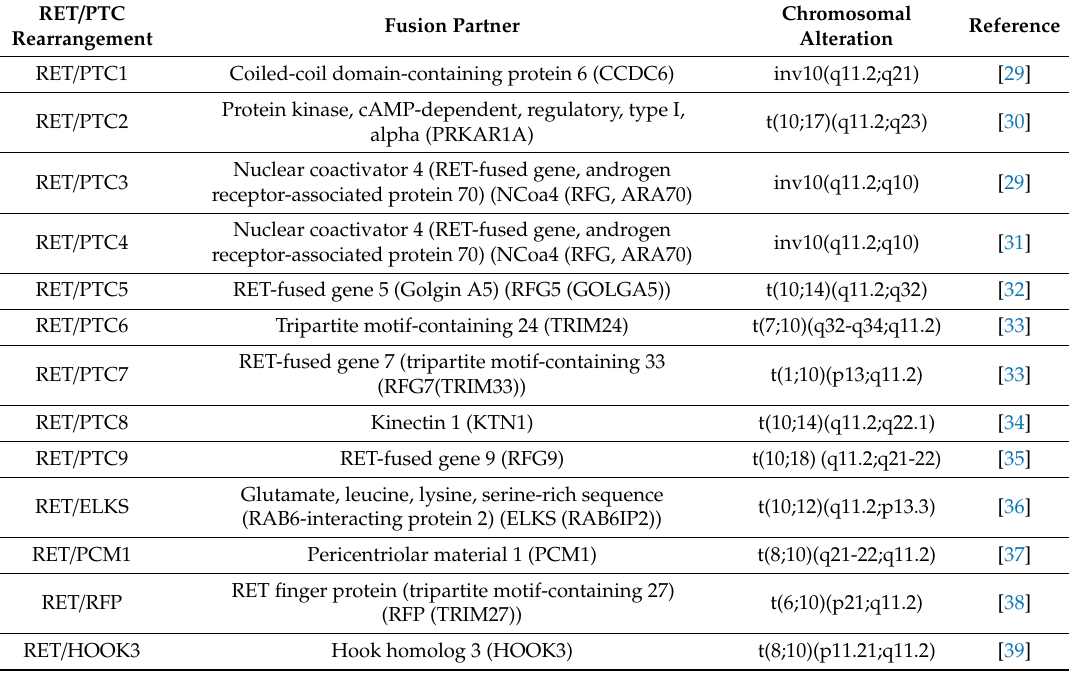
Table 1. RET / PTC oncoproteins related with thyroid